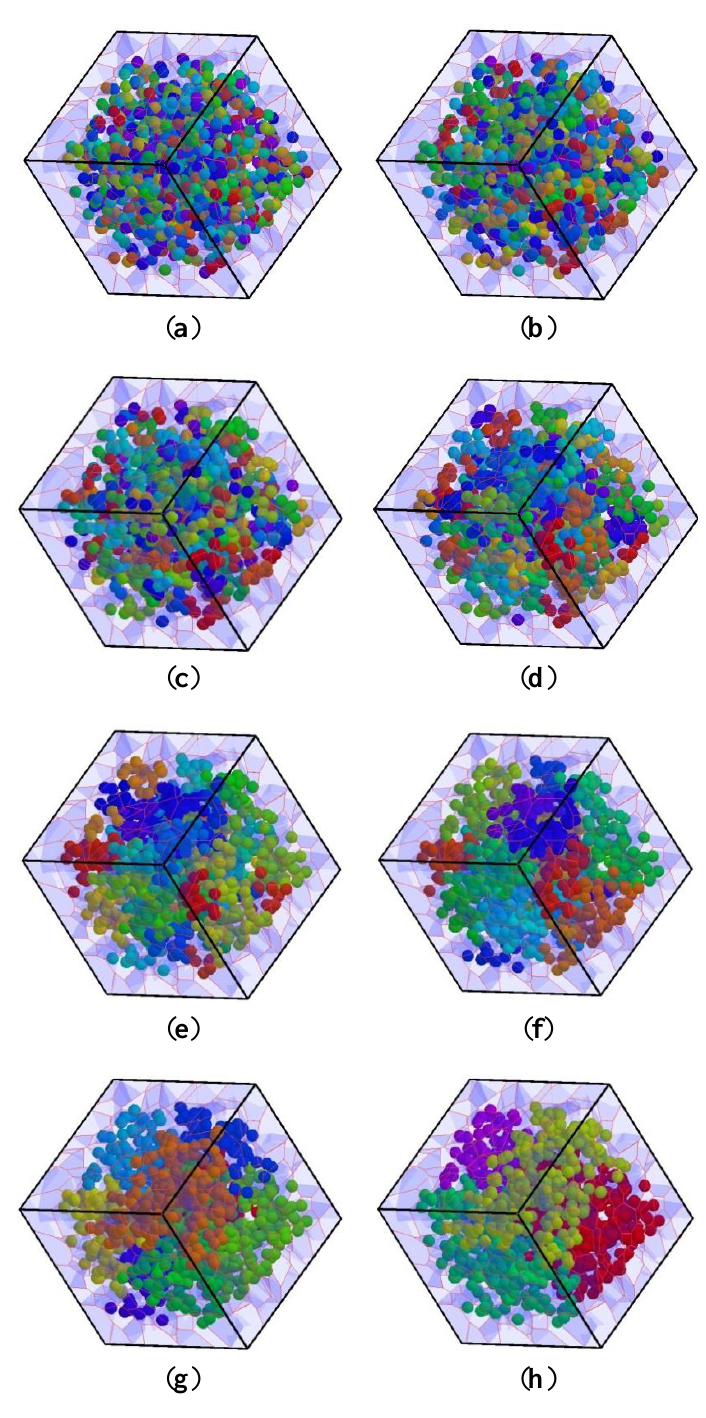
Figure 7. Simulation of continuous clustering progression in different cluster numbers based on Euclidean distance and neighbor relationship: ( a ) 1000; ( b ) 500; ( c ) 250; ( d ) 125; ( e ) 60; ( f ) 30; ( g ) 10; and ( h )